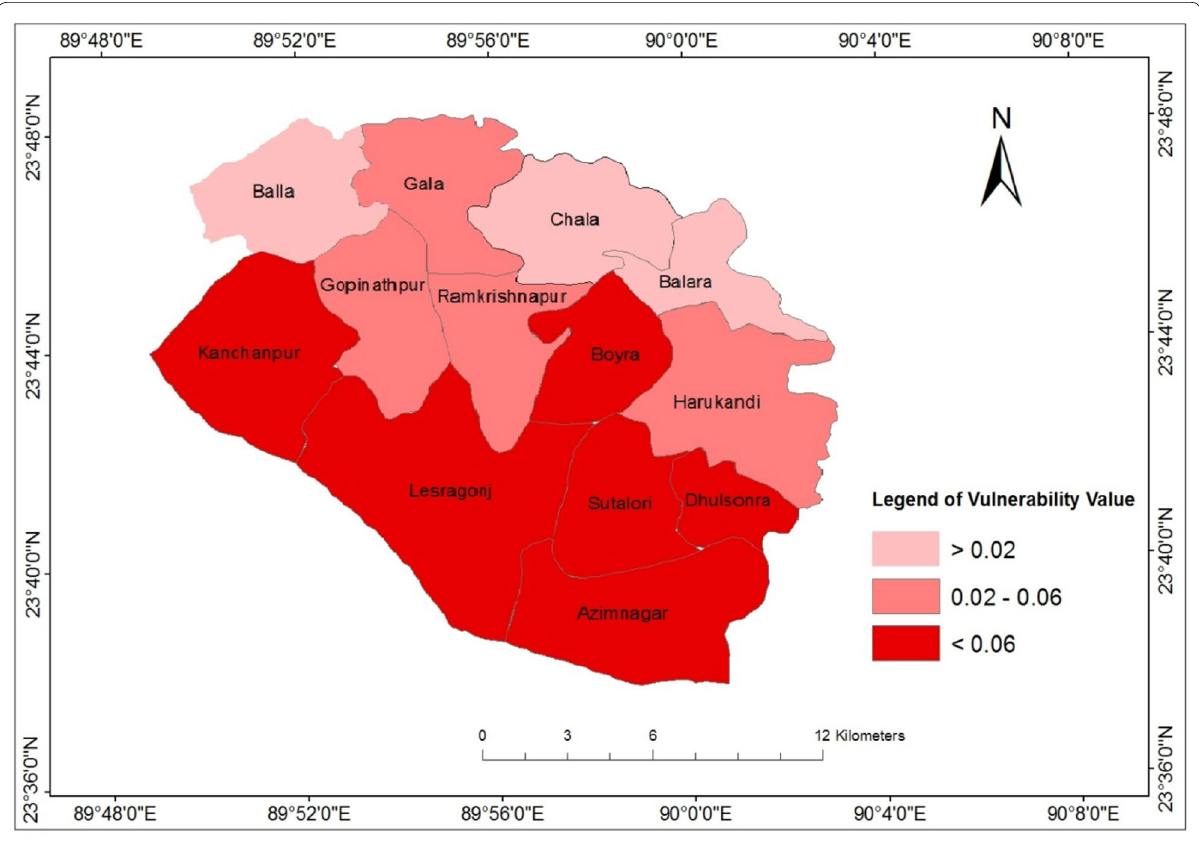
Fig. 6 Vulnerability map of the study